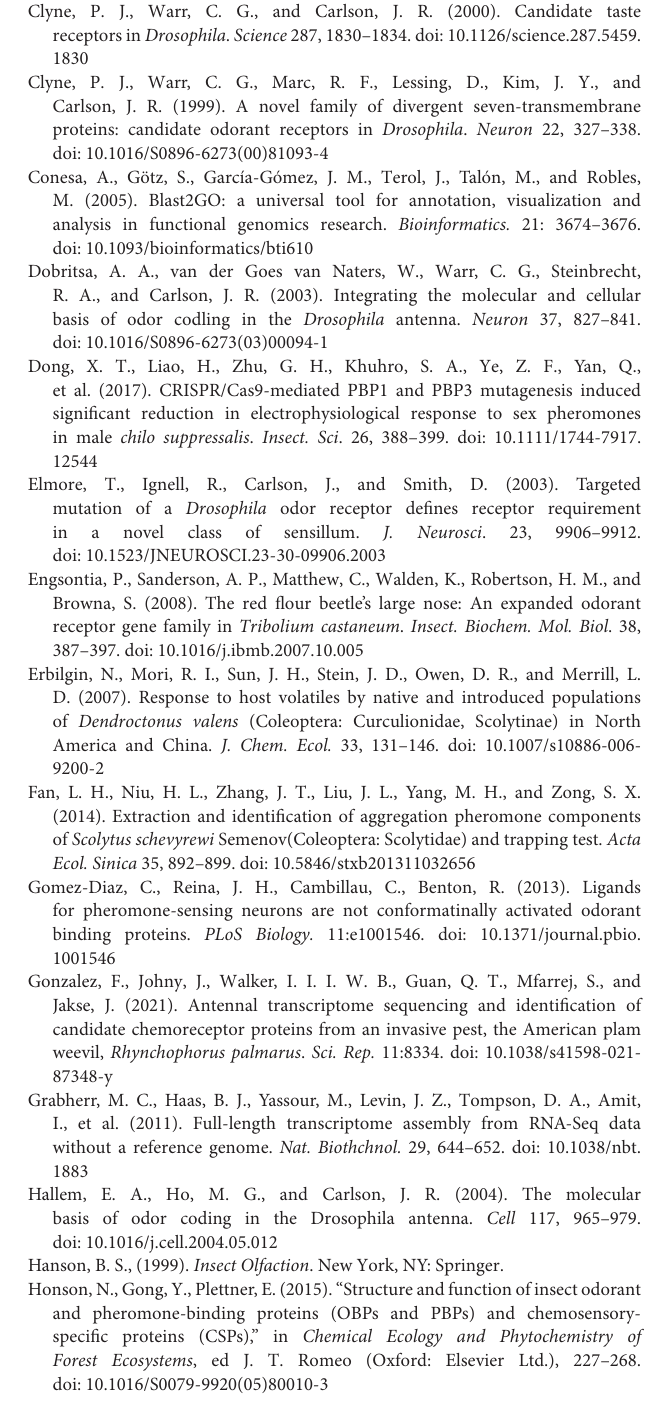
Supplementary Figure 1 | GO classification analysis of unigenes in all-unigene. GO functions are shown in the X-axis. The right Y-axis shows the number of genes that have the GO function, and the left Y-axis shows the percentage. Supplementary Figure 2 | Uncropped gel images of candidate ScosOBPs and candidate ScosCSPs. A, antennae; H, head; T, thorax; Ab, abdomen; L, leg; W, wing; ck, control [ultra-pure water (germ free)].